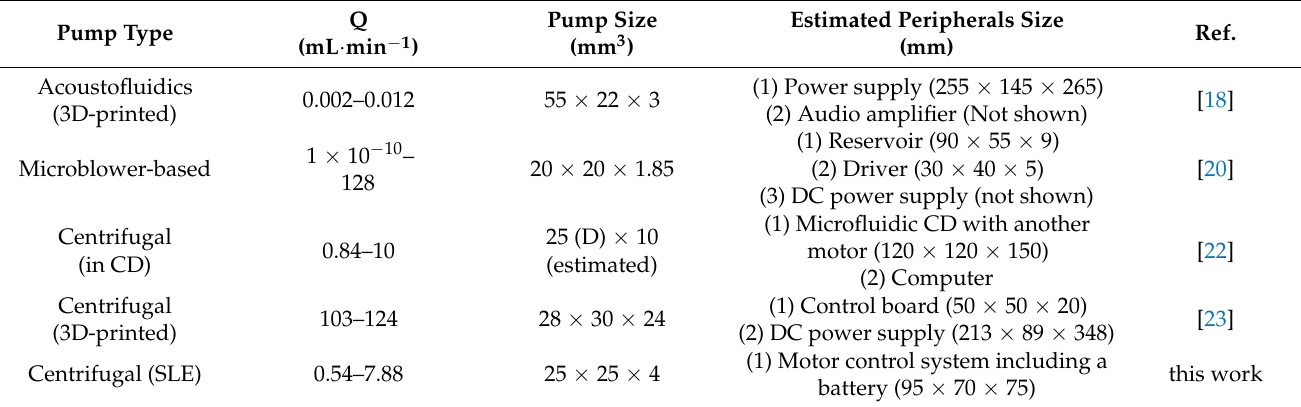
Table 1. Comparison of miniaturized pumps with our